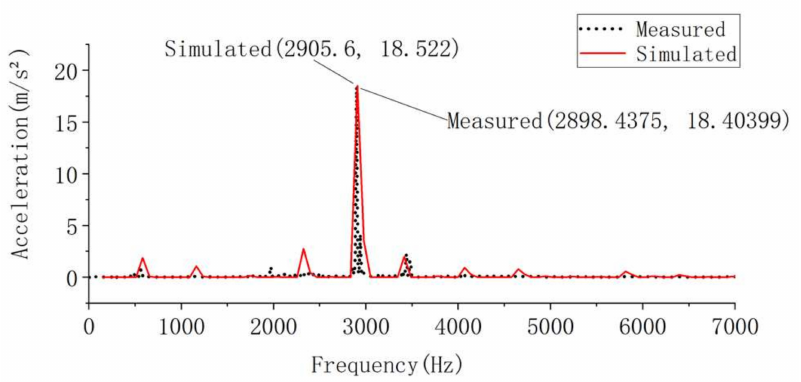
Figure 18. Experimental platform. ( a ) The arrangement of the experimental equipment. ( b ) The position of the vibration acceleration sensor. Figure 19 shows a comparison of the vibration accel- eration on the surface of the motor housing in the finite element simulation and the actual test. In the simulation, the motor torque was exactly the same as the actual test torque. On this basis, the appropriate damping coefficient was set. In this case, the simulation results agreed with the actual test results, which verified the accuracy of the simulation and ensured the accuracy of the optimization method proposed in this paper.